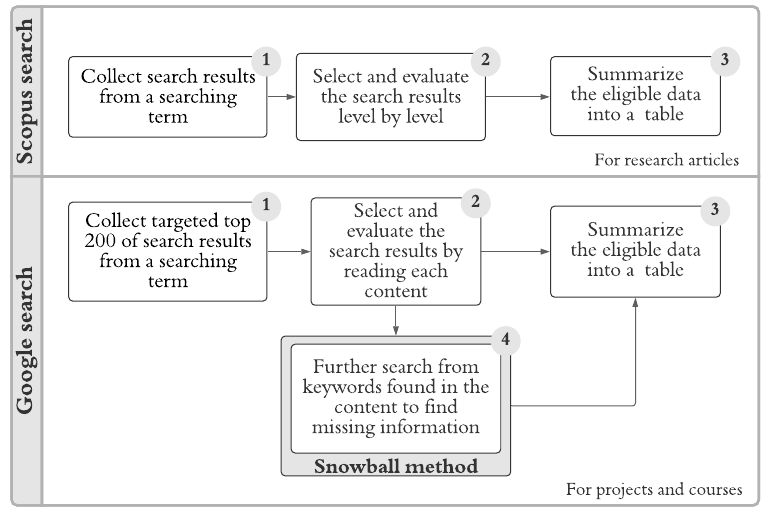
Figure 2. A workflow of data